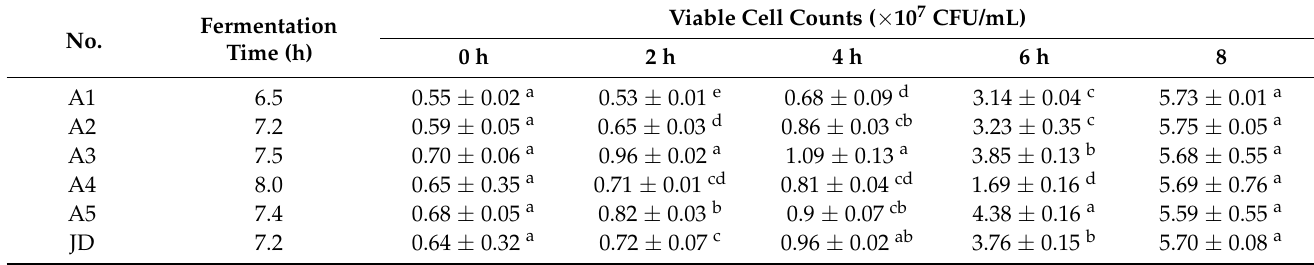
Table 1. Changes in viable cell counts of yogurts produced during fermentation using different ratios of L. delbrueckii subsp. bulgaricus IMAU20312 and S. thermophilus IMAU80809 in starter cultures compared with the commercial starter